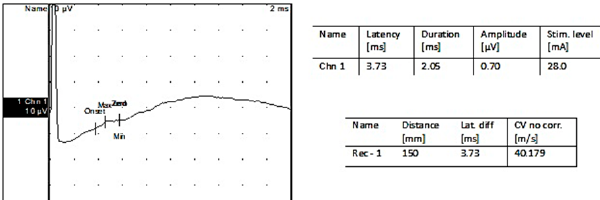
Figure 5. Sensorynerveconduction: Left suralnerve.